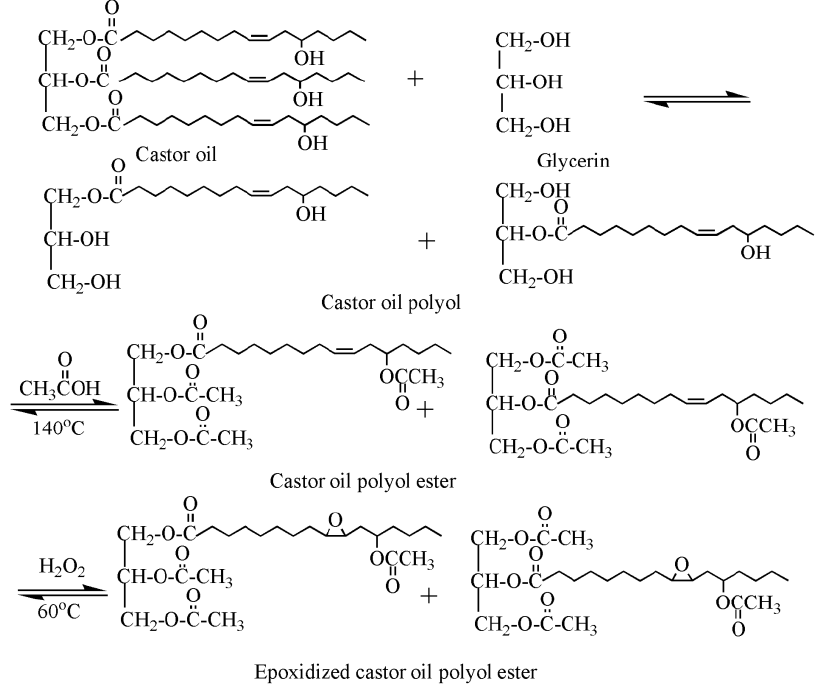
Figure 2. Synthesis of epoxidized castor oil polyol ester.